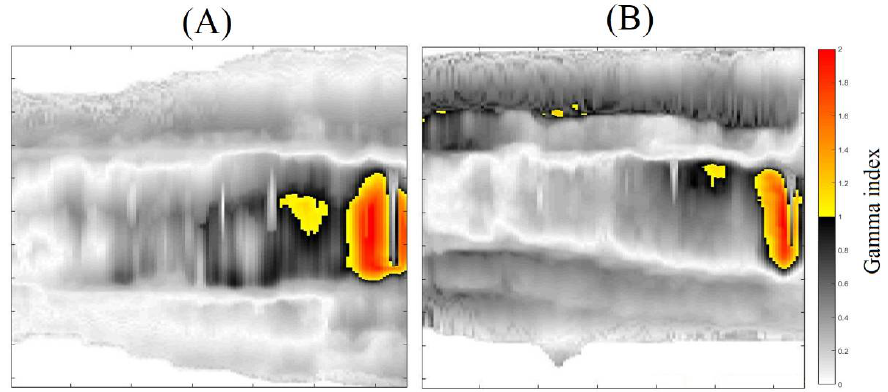
Figure 7. Gamma map images for the sagittal ( A ), and Coronal plans ( B )—Threshold of 20%.